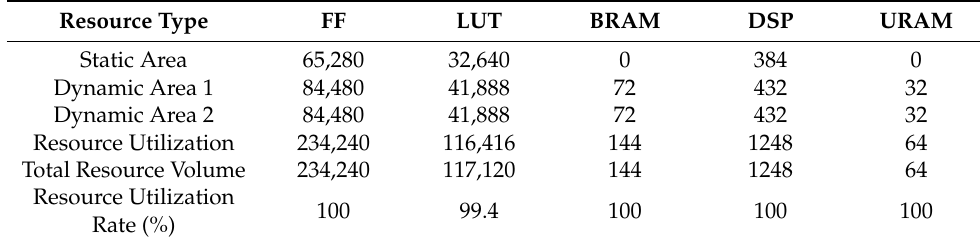
Table 2. Hardware resource consumption of EDRCA accelerator in Xilinx KV260 FPGA.